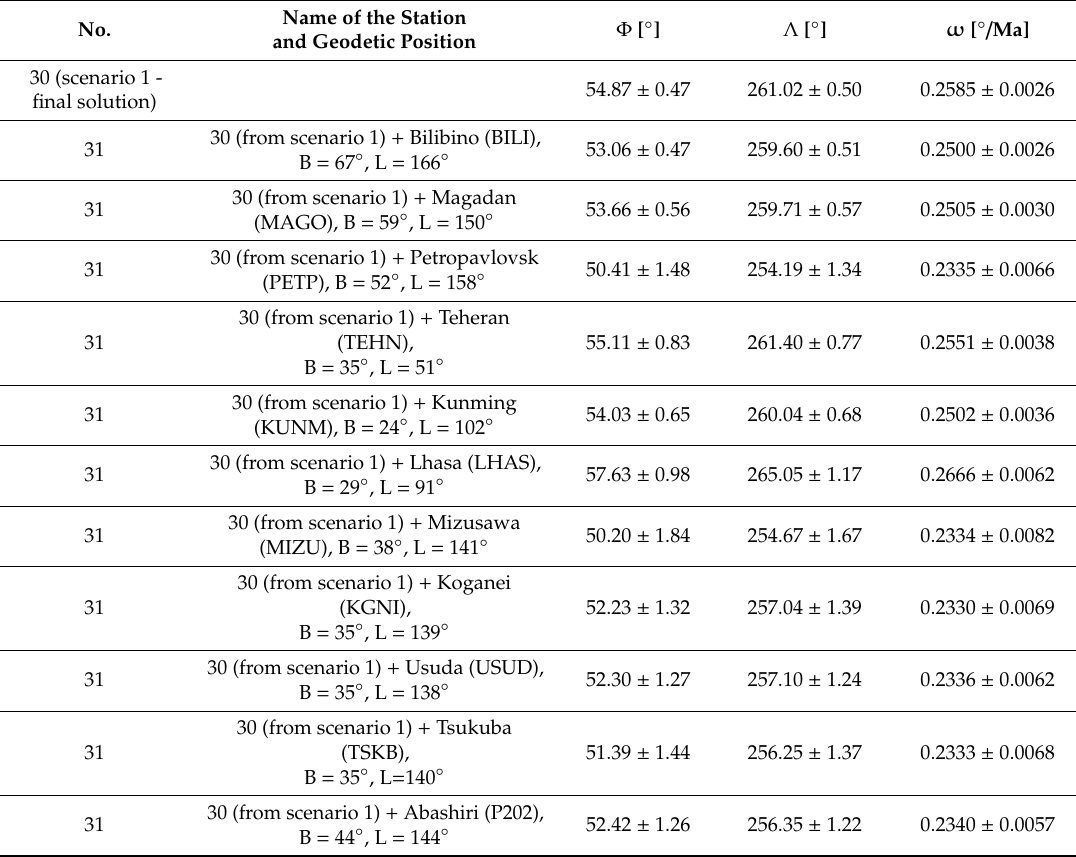
Table 1. Eurasian plate motion parameters obtained after adding individually selected stations (given in Appendix A) that are not consistent with the Eurasian plate motion or are not located on the Eurasian plate to calculation scenario